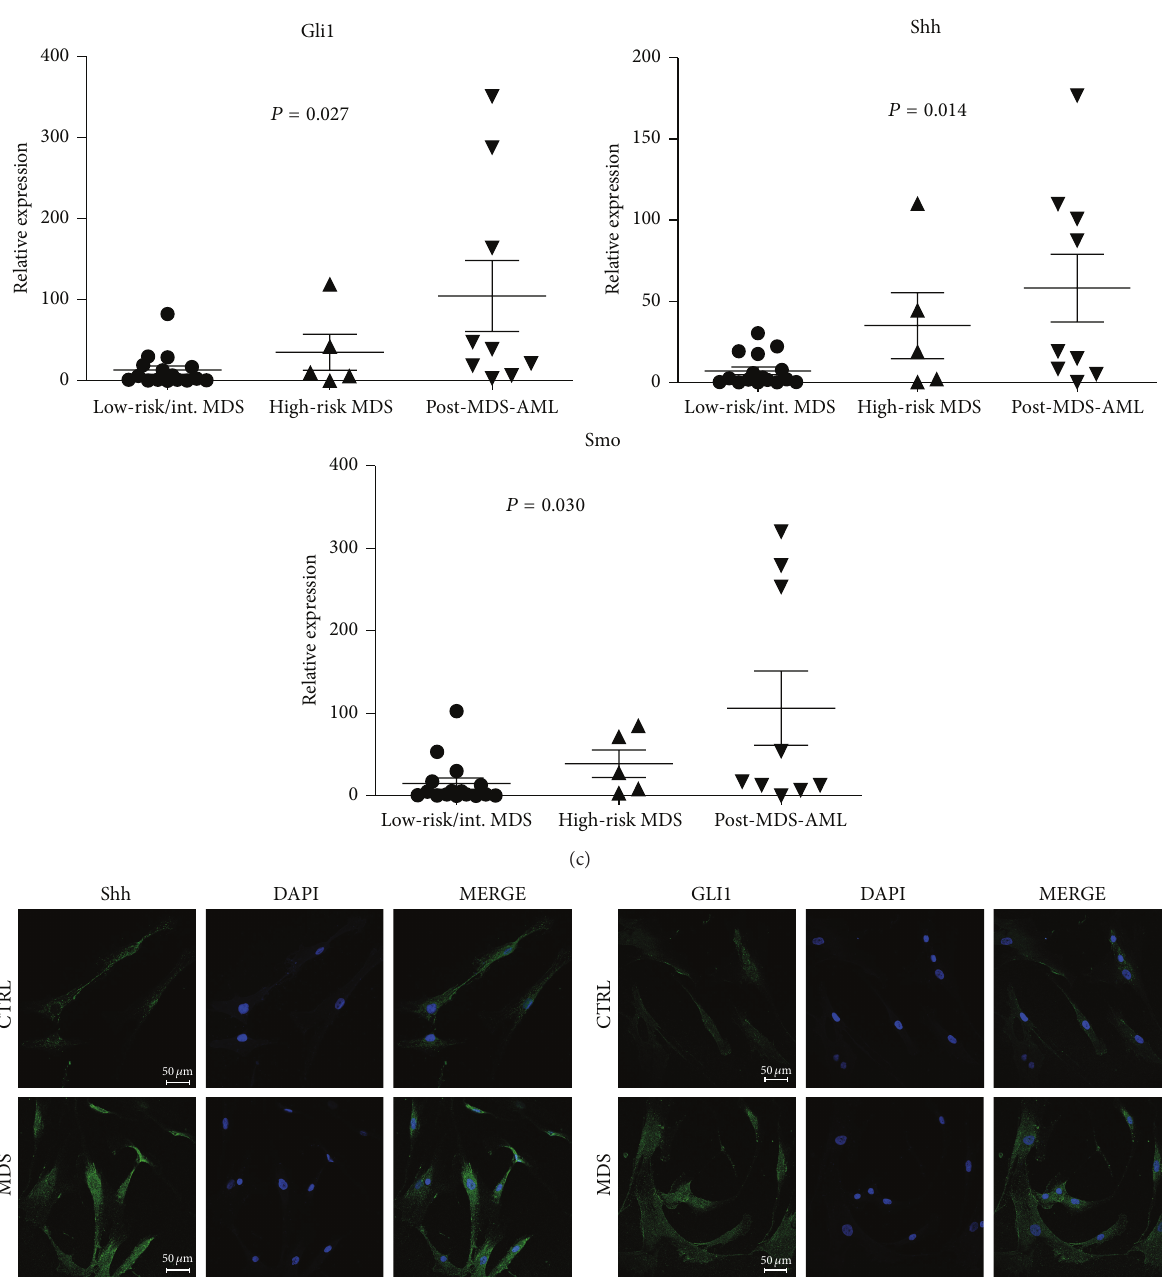
Figure 1: Activation of Shh signaling in MDS. Mean fluorescence intensity (MFI) of CD34, CD45, CD14, CD90, CD29, and CD105 was determined in BMSCs of MDS patients and healthy donors by flow cytometric analysis. Representative histograms are shown. Green line represents the respective isotype control and red line represents MDS-derived BMSCs (a). Representative micrographs of primary BMSCs and CD34 + stem cells ((b), × 200). Real-time PCR analysis of Gli1, Shh, and Smo in primary BMSCs ( 𝑛 = 30 ) from MDS and post-MDS AML marrow samples (c). Immunofluorescence images of SHH and GLI1 protein in primary bone marrow-derived mesenchymal stromal cells from MDS patients and healthy donors (CTRL) are shown